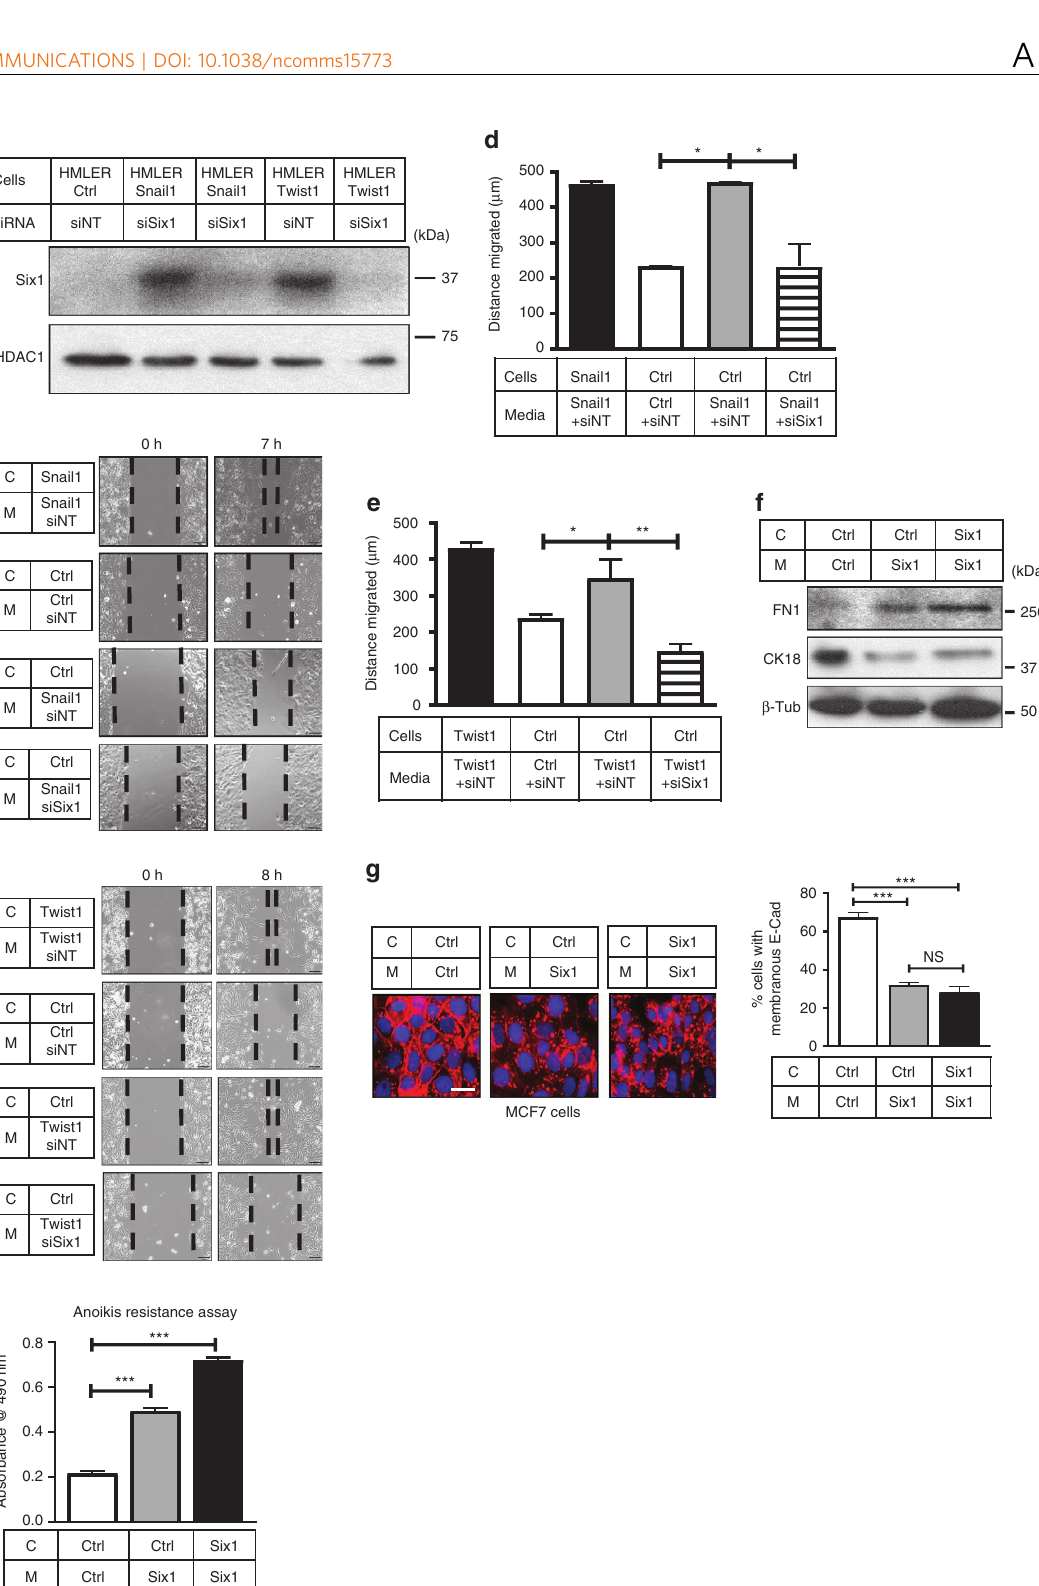
Figure 2 | Six1 is necessary (downstream of Snail1/Twist1) and sufficient to mediate NCA effects. ( a ) Western blot analyses performed on WCLs from HMLER-Ctrl, HMLER-Snail1 and HMLER-Twist1 cells transfected with 150nM of siSix1 or a non-targeting small interfering RNA (siRNA) pool (siNT). HDAC1, loading control. ( b , c ) Representative 7–8h migration assay of HMLER-Ctrl cells in CM from HMLER-Snail1 or Twist1 cells ± siSix1. ( d , e ) Quantification of cell migration in b , c . ( f ) Western blot analyses performed on WCLs from MCF7-Ctrl and MCF7-Six1 cells cultured in indicated CM for 48h. b -Tub, b -Tubulin, loading control; CK18, cytokeratin 18; FN1, fibronectin. ( g ) Representative ICC of E-Cad (red) in MCF7-Ctrl and Six1 cells cultured in indicated CM for 48h (DAPI, blue). Quantification of % membranous E-Cad, n Z 100; scale bar, 20 m m. ( h ) Representative anoikis resistance graph (plotted as absorbance as a measure of cell number) of MCF7-Ctrl or MCF7-Six1 cells cultured in indicated CM for 24h. C-cells, M-Media; Scale bar, 100 m m, s.e.m. shown, n Z 3, one-way ANOVA with Tukey’s post test in all cases; NS, not significant; * P o 0.05, ** P o 0.01 and *** P o 0.001.